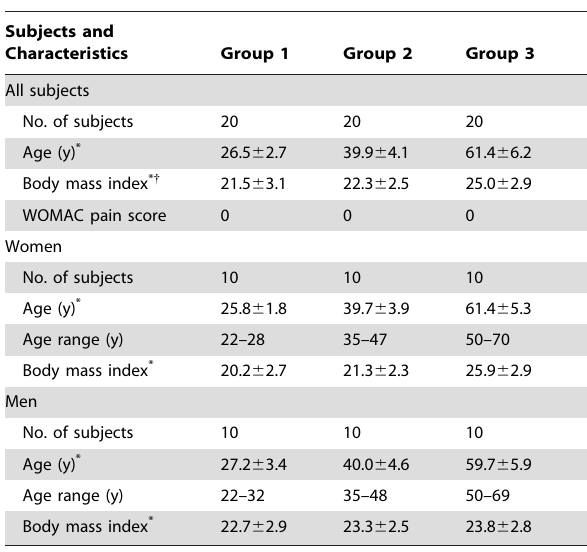
Table 1. Subject characteristics.